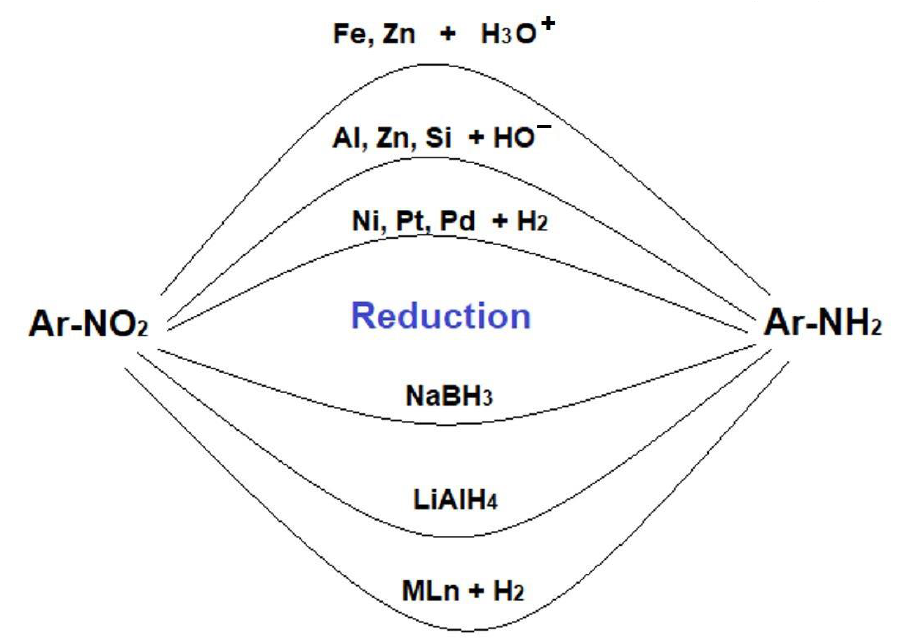
Figure 2. Reduction of aryl-nitro derivatives to anilines.